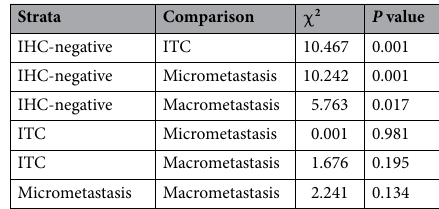
Table 4. Subgroup survival analyses between different tumor deposit group in lymph